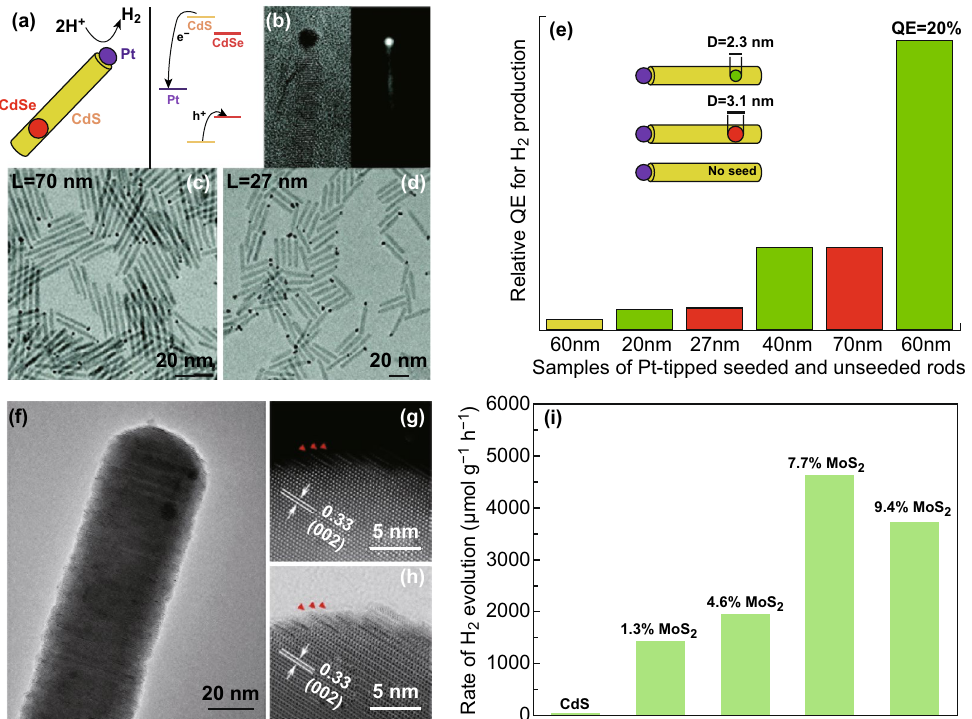
Fig. 10 a Schematic illustration of the multi‑component heterostructure and energy band diagram of a Pt‑tipped CdS rod with an embedded CdSe seed. b The Pt tip is clearly seen in the HRTEM and HAADF‑STEM images. TEM images of Pt‑tipped seeded rods with the lengths of c 27 nm and d 70 nm on average. e Relative quantum efficiency for hydrogen production, obtained from Pt‑tipped unseeded CdS rods (yellow), and five different samples of Pt‑tipped seeded rods with seed diameters of 3.1 (red) or 2.3 nm (green). Reproduced with permission from Ref. [176]. Copyright 2010, American Chemical Society. f TEM image of a CdS‑MoS 2 heterostructure. g HAADF‑STEM and h ABF‑STEM images of the tip area of a CdS‑MoS 2 heterostructure. The red triangles indicate the position of MoS 2 NSs. i Comparison of H 2 production activities using CdS NWs and CdS‑MoS 2 heterostructures with different loading amounts of MoS 2 NSs as catalysts. Reproduced with permission from Ref. [117]. Copyright 2017, American Chemical Society. (Color figure